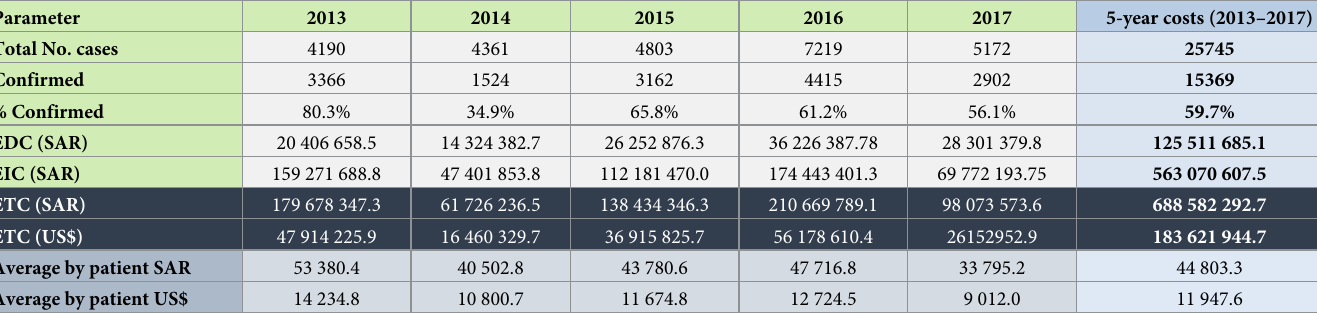
Table 6. Estimated dengue costs in Saudi Arabia during the period